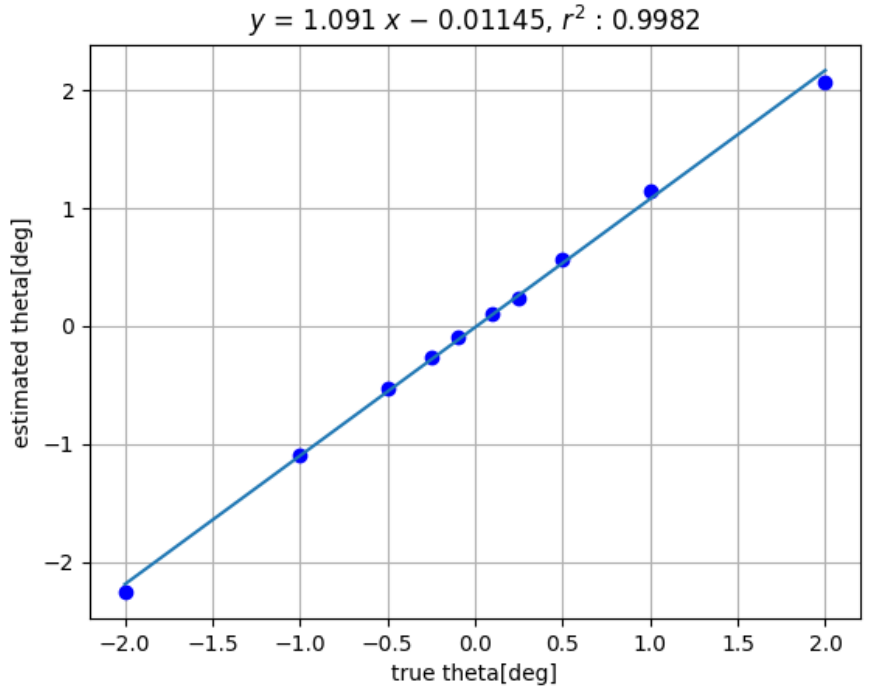
Figure 14. Result of estimation for tilt angle θ by method 2 with camera